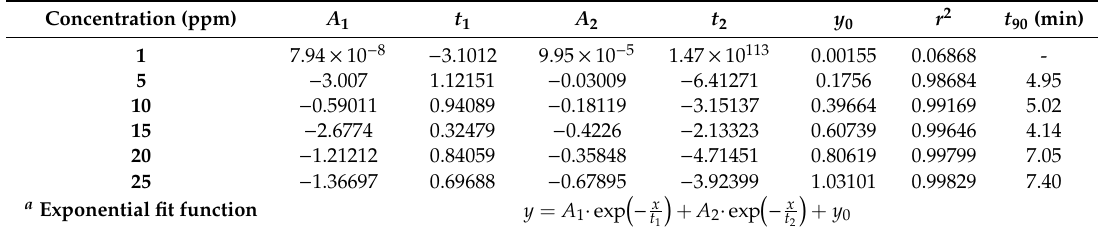
Table 2. Overview of response times ( 𝑡 (cid:2877)(cid:2868) -values) for detection of VOCs in water with the respective utilized polymer membrane.